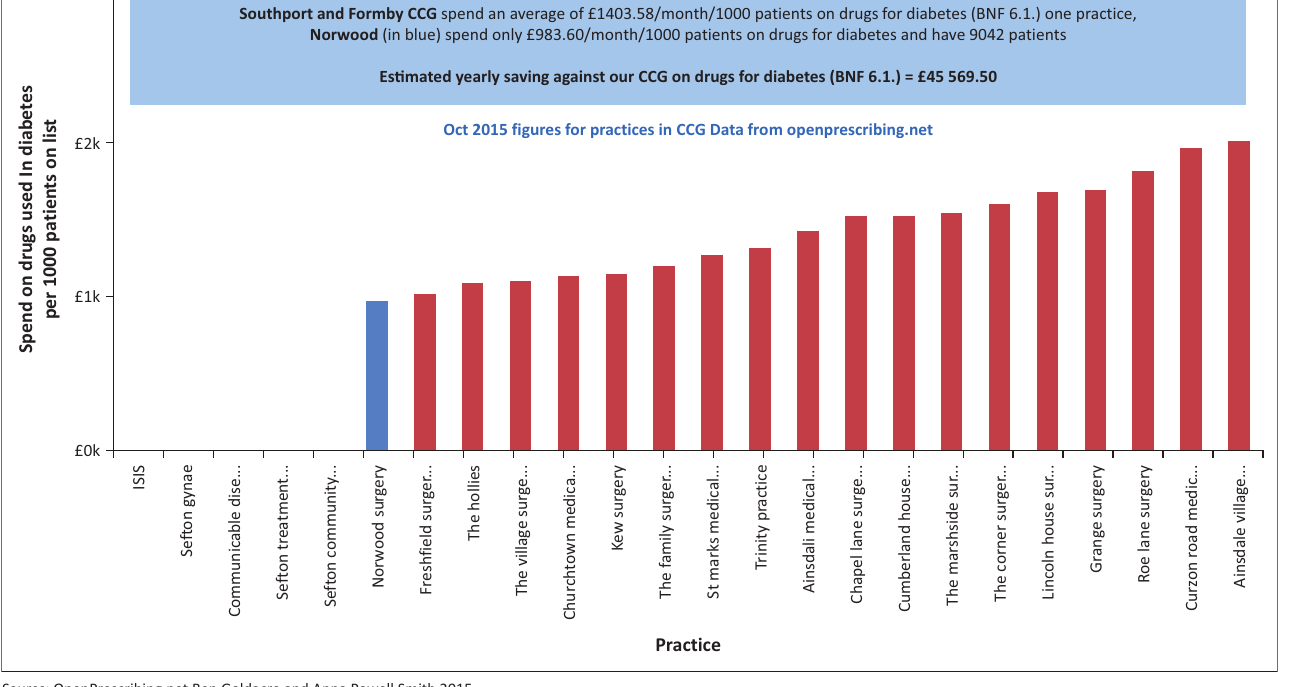
FIGURE 3: Norwood surgery spends the least in Southport and Formby CCG on drugs for